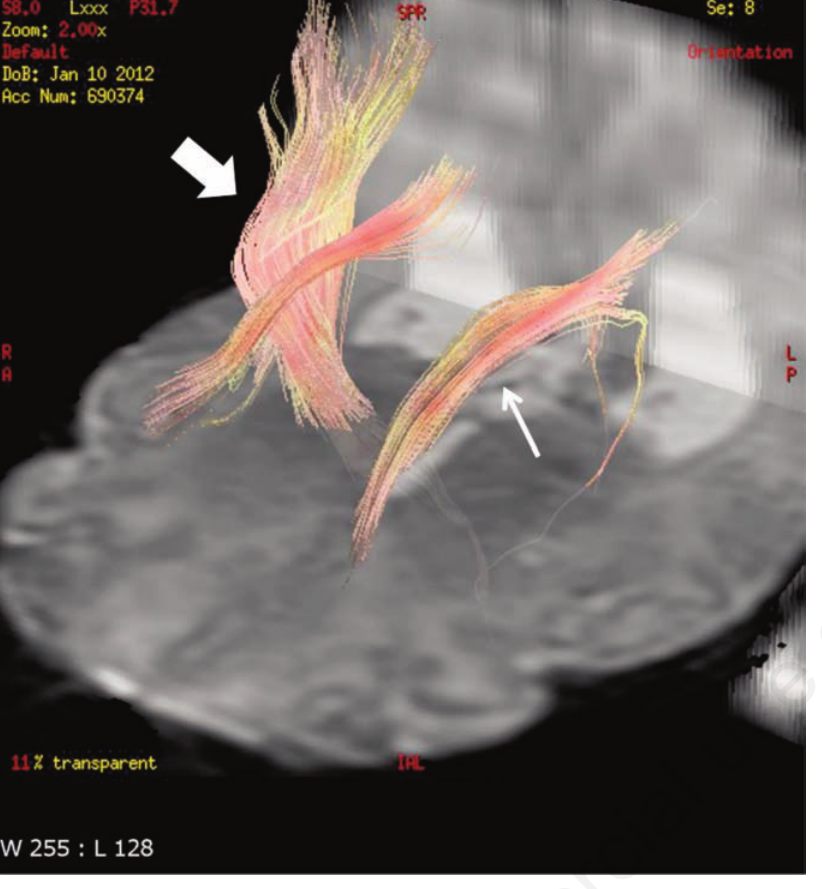
Figure 2. Tractography. Probst bundle parallel to the lateral ventricle (thin arrow). Corticospinal tract (thick